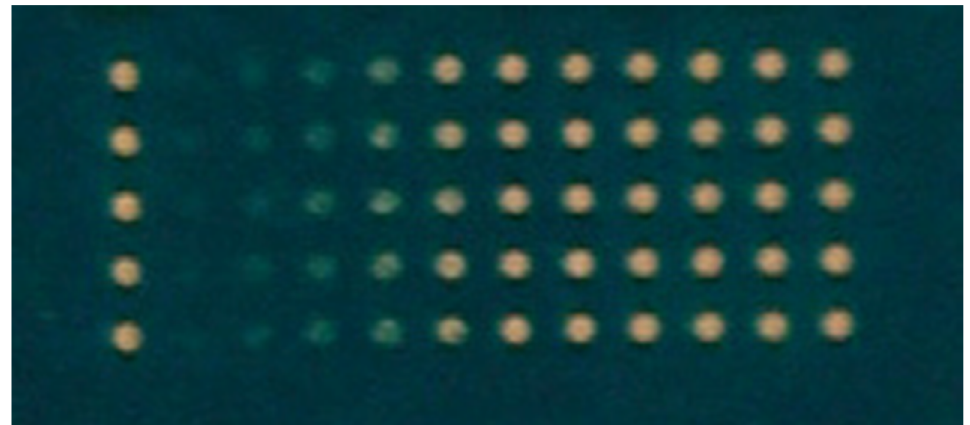
Figure 2. A microscopic image of a matrix of craters generated for evaluation of ablation efficiencies in the layers studied. The craters were 0.3 mm in diameter and the laser fluence per pulse was 0.6 Jcm − 2 . A computer controlled translational stage was used to laterally move the sample with respect to the laser focus and to generate the grid shown. The number of laser shots used for ablation increases from 5 to 55 at 5 shot increments from left to right. The spot column on the far left represents completely removed coating after 60 UV laser shots.